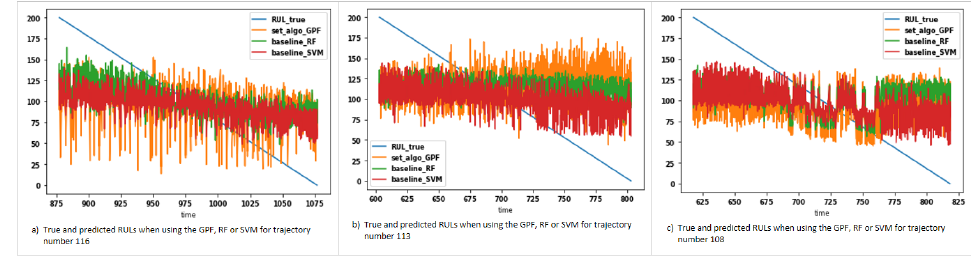
Figure 18. Trueand predicted values for three different trajectories of the SCU test set when using the GPF, RF, and SVM (cut 200 FC before failure).